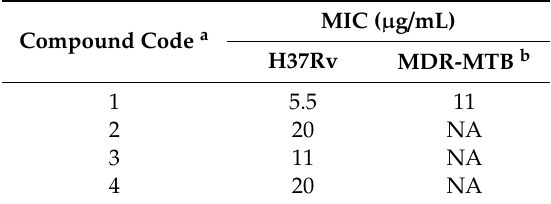
Table 1. In vitro anti-TB activity of compound 1 and its Schi ff bases 2 , 3 , and 4 against H37Rv and MDR strains of MTB.